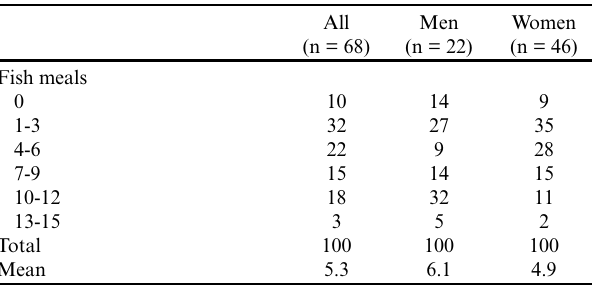
Table 5 . Frequency distributions (%) of fish meals/week according to